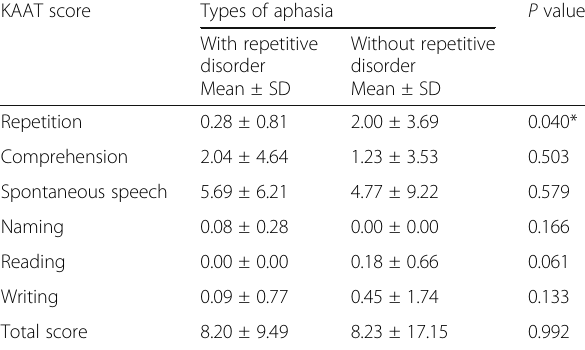
Table 3 Comparing KAAT score at onset between aphasia with repetitive disorder and without repetitive